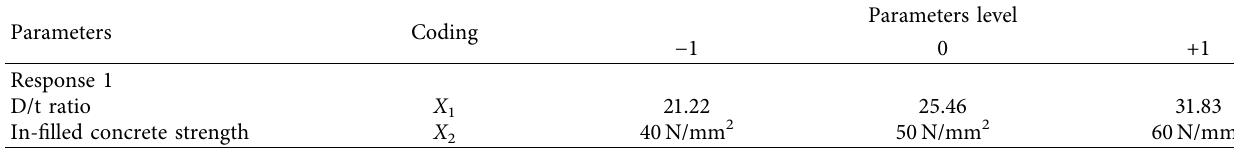
Table 1: CCD model Parameters level.